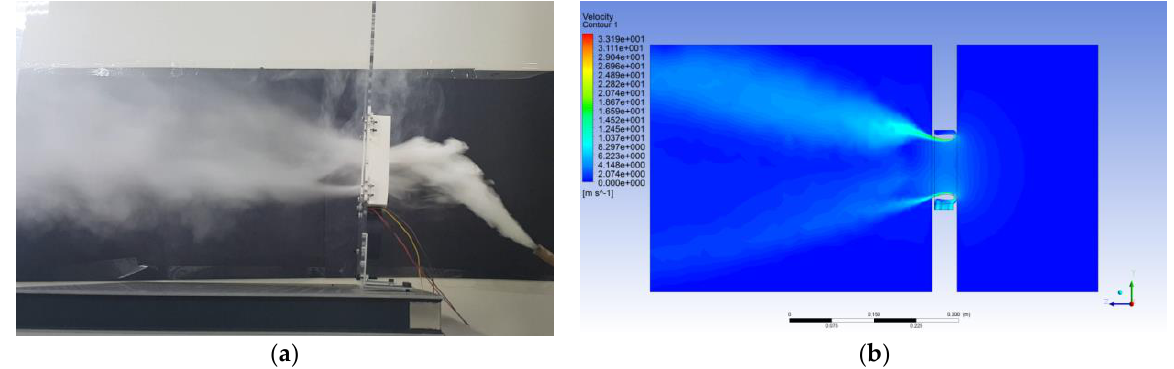
Figure 14. ( a ) Experimental and ( b ) simulated flow-field measurement results.